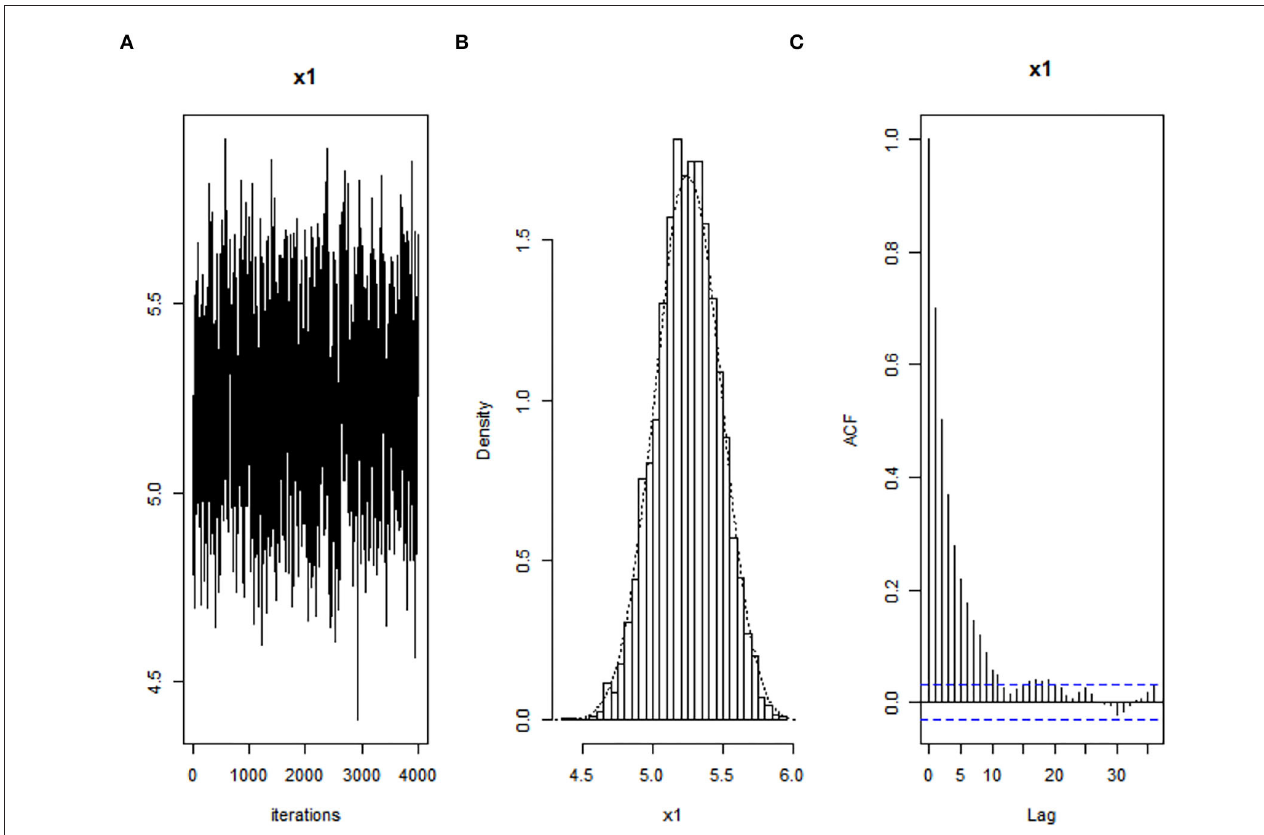
FIGURE 3 | Convergence diagnostics of parameter ˆ β 1 for non-normal error when τ density plot, and (C) autocorrelation plot.